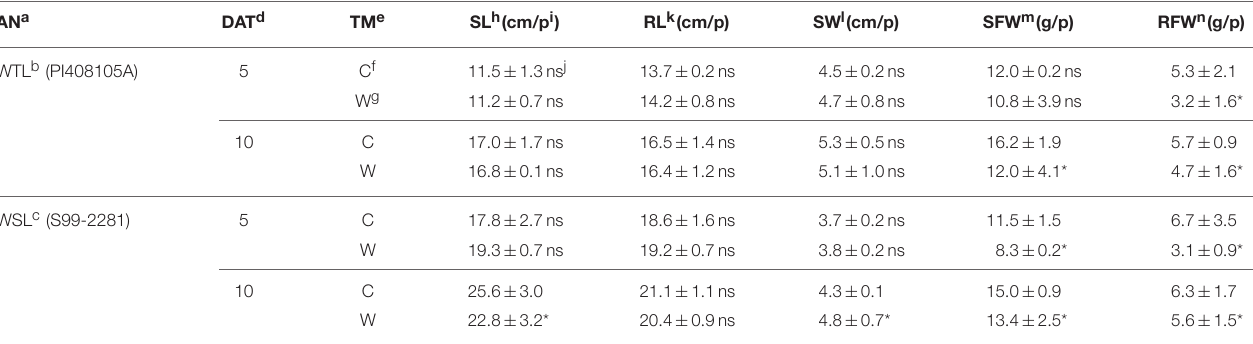
TABLE 4 | Effect of waterlogging stress on shoot length, root length, shoot width, and their respective weights of WTL and